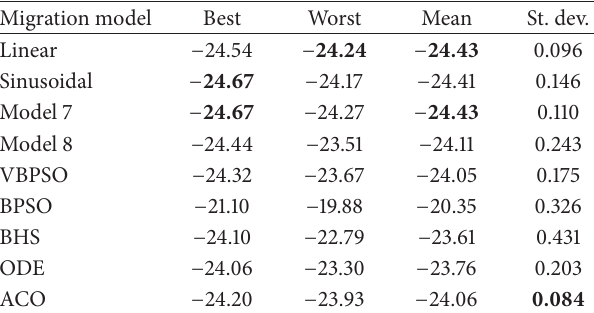
Table 3: Comparative results for 300-element symmetric thinned array. The smaller values are in bold. Migration model